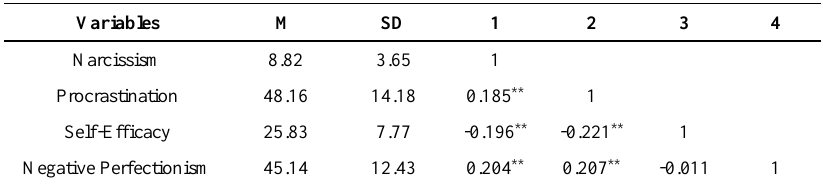
Table 1. Descriptive Statistics and Correlations.